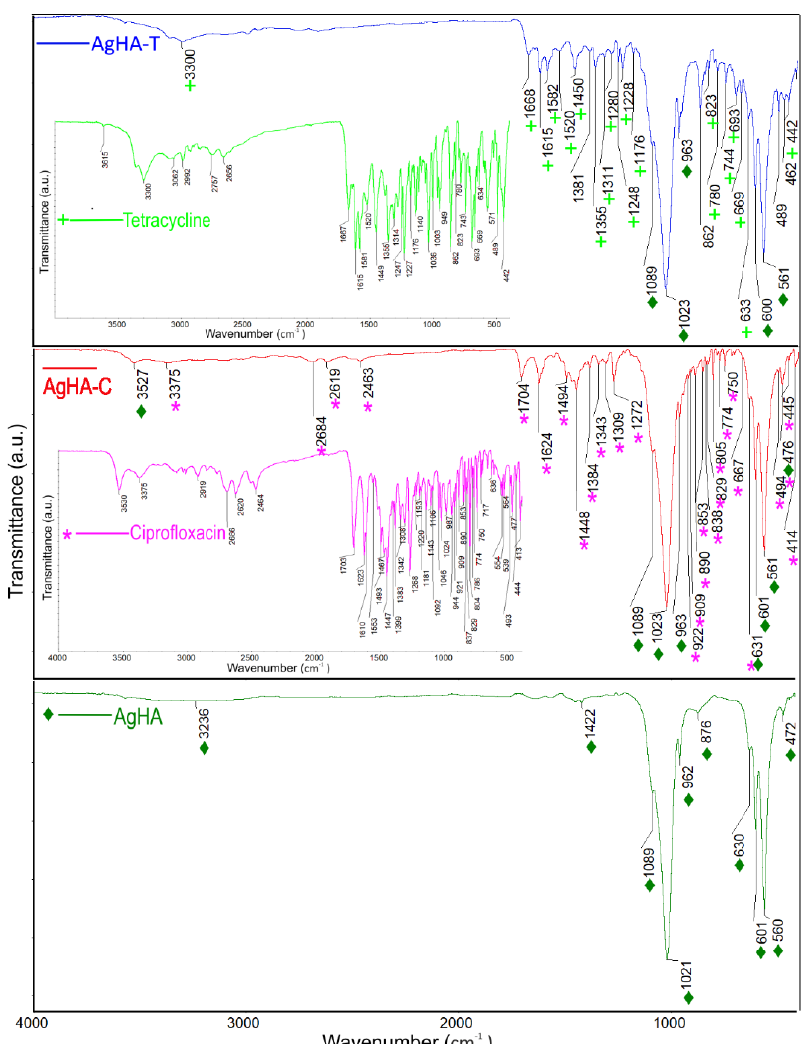
Figure 3. FTIR spectra of AgHA, AgHA-C and AgHA-T as well as the spectra of the two antibiotics, Ciprofloxacin and Tetracycline. (cid:7) —peaks associated to HA; ∗ —peaks associated to Ciprofloxacin; + — peaks associated to Tetracycline.